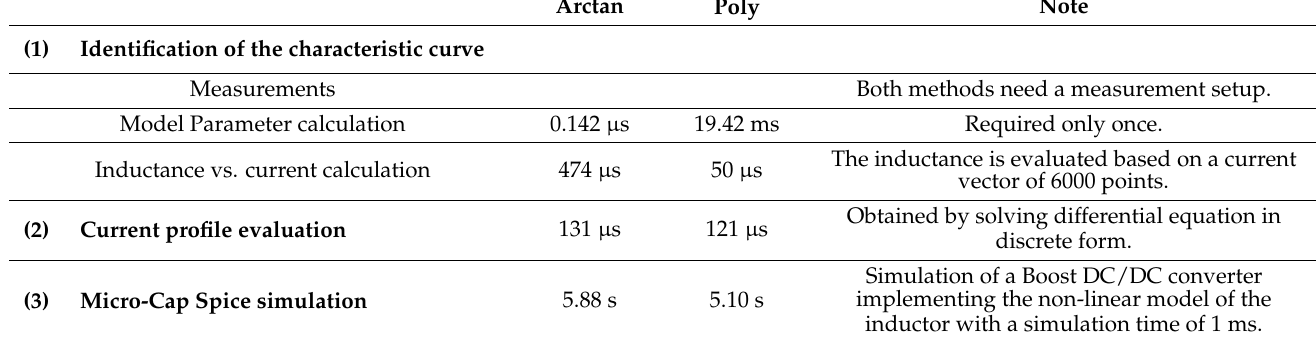
Table 2. Computation time